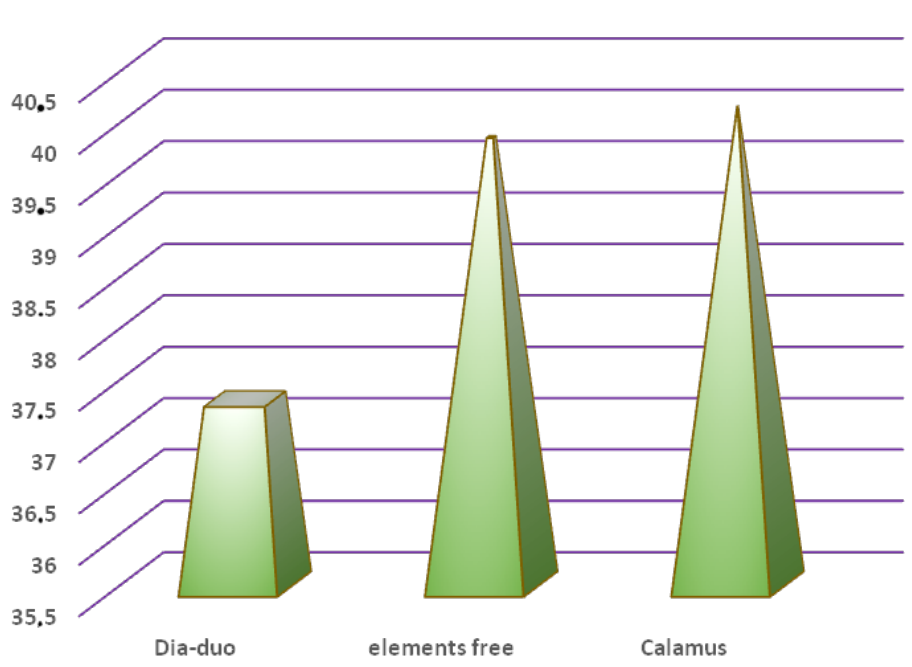
Figure 5. Average temperatures at − 2 mm of the three systems compared. The data show no statistically significant differences ( p = 0.197).